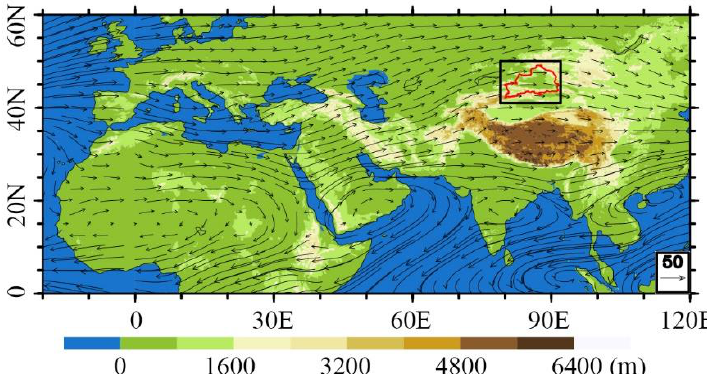
Figure 4. Mean of the vertically integrated moisture flux during the snow season changes from 1980 to 2017 from the surface to 0.1 hPa in Northern Xinjiang which is framed by a red polygon. Moisture flux is expressed in kg / m ·